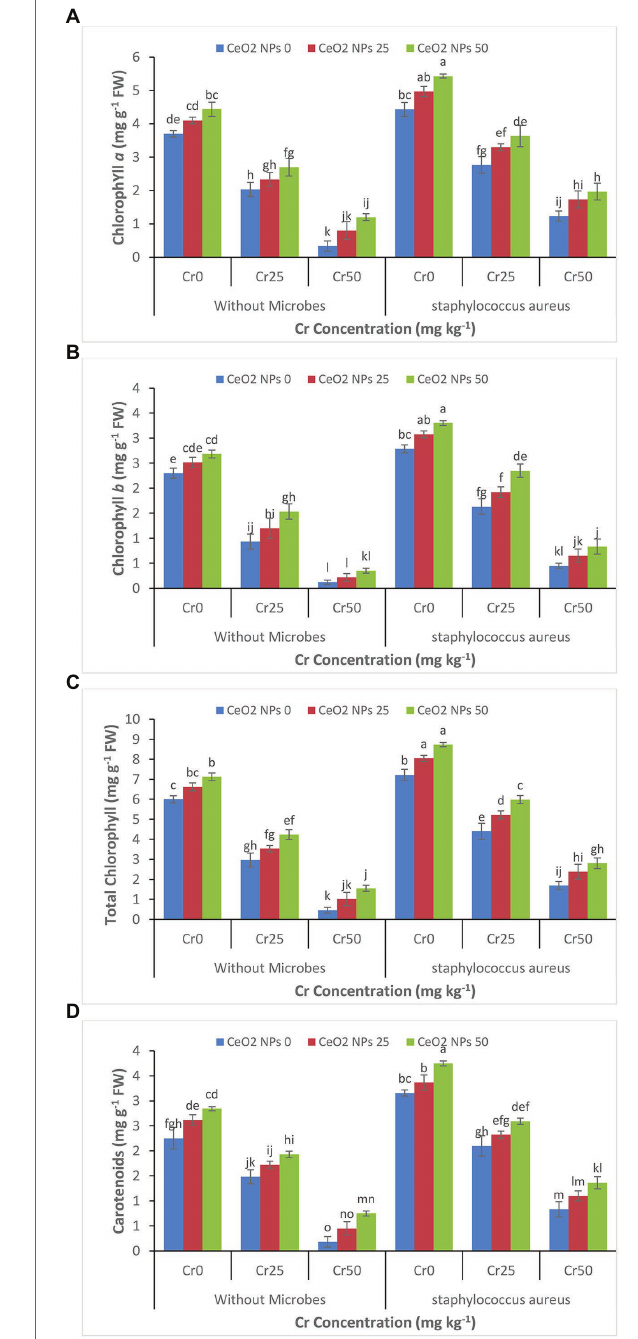
FIGURE 2 | (A–D) : Effect of CeO 2 NPs and Staphylococcus aureus on photosynthetic rate (A) , transpiration rate (B) , stomatal conductance (C) , and water use efficiency (D) in sunflower plant under Cr stress. The given values are means of three replications with standard deviation. The alphabets represent the significant/non-significant difference at p ≤ 0.05.